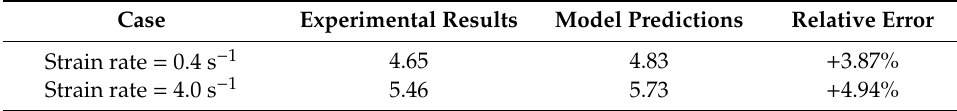
Table 3. Hysteretic area obtained from experimental results and model